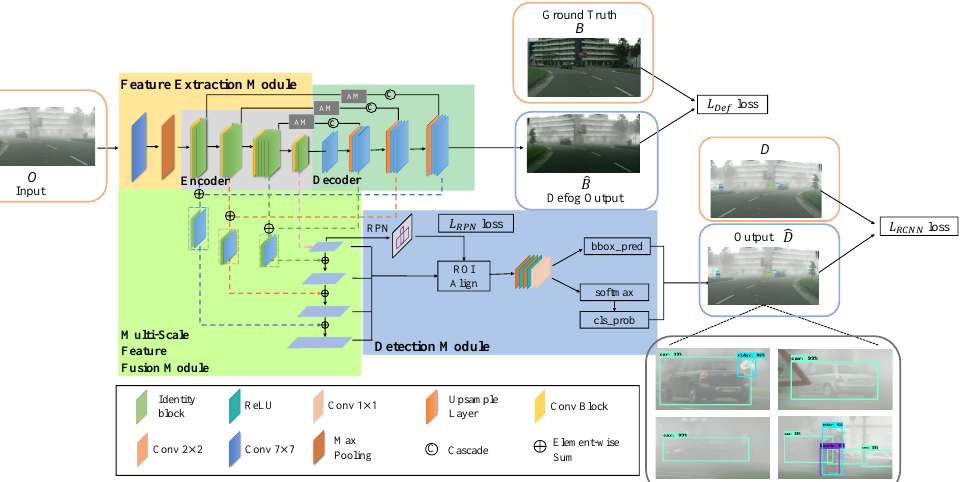
Figure 3. Framework overview for our JSFR . Input elements are marked by the orange boxes including the images O degraded by fog, the clean background images B , and ground truth images D labeled with class and bounding box. Output elements are marked by a blue box, including medium defog output ˆ B and final object detection results output ˆ D . To see the results more clearly, we zoom in on the detection results for the final output image, as shown in the grey box. The orange/cyan/green/blue blocks represent the feature extraction module/UNet decoder/information fusion module/detection module, respectively.